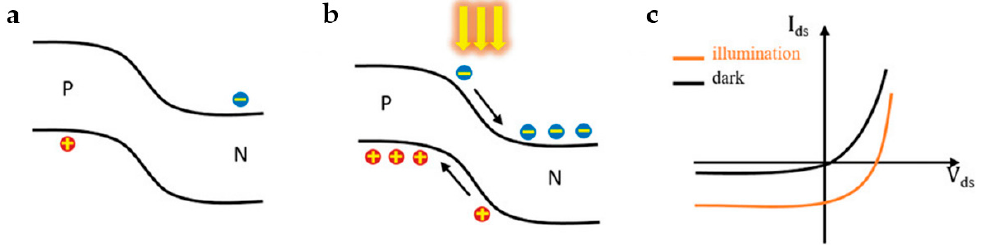
Figure 2. Schematic band diagrams of the p − n junctions ( a ) without illumination and ( b ) under illumination. ( c ) I − V characteristic of a p − n junction with and without illumination. (Reprinted with permission from ref. [9] . Copyright 2021 John Wiley and Sons Publications).